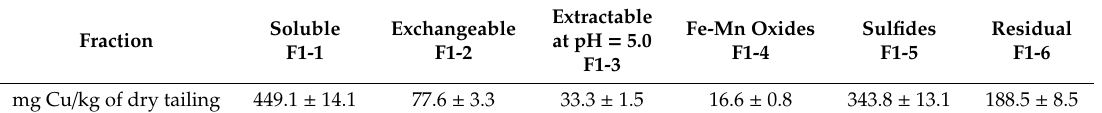
Table 1. Copper concentration in mg Cu / kg of dry tailing in each fraction. Sample analyzed by the six-fraction procedure.